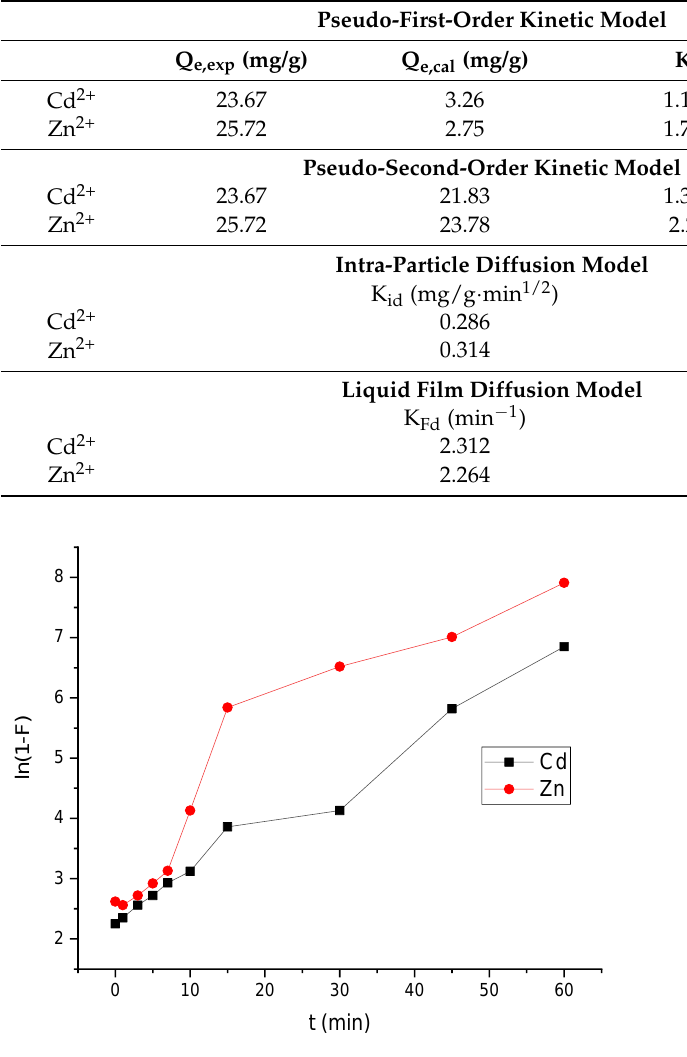
Figure 12. Liquid film diffusion process for the adsorption of HAp-based composites. Table 3. Thermodynamic parameters of Cd 2+ and Zn 2+ adsorption on HAp/CTs 20/80 composite.